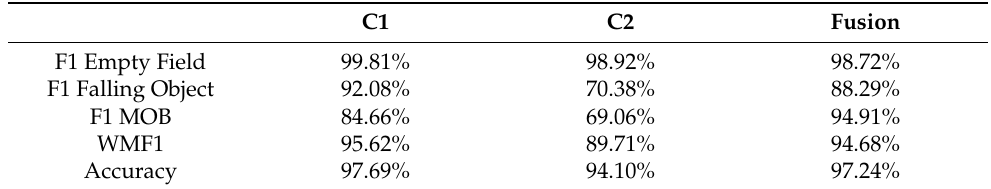
Table 4. Most useful metrics of the classifiers and their fusion used for comparison among different approaches.